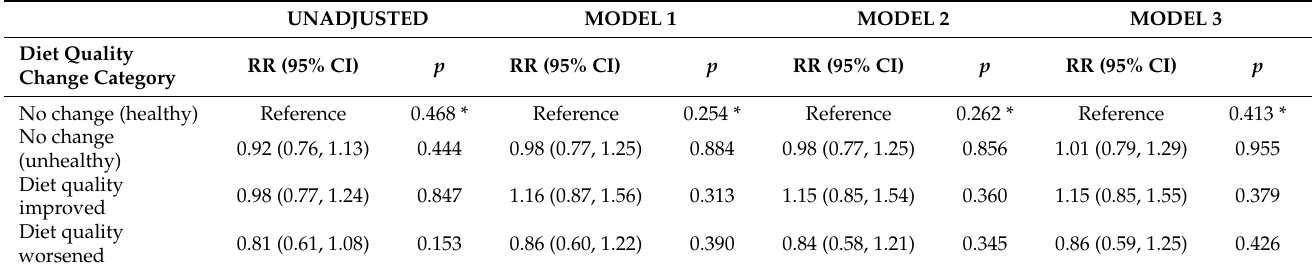
Table 5. Results from generalised linear models investigating the association between diet quality change and fertility